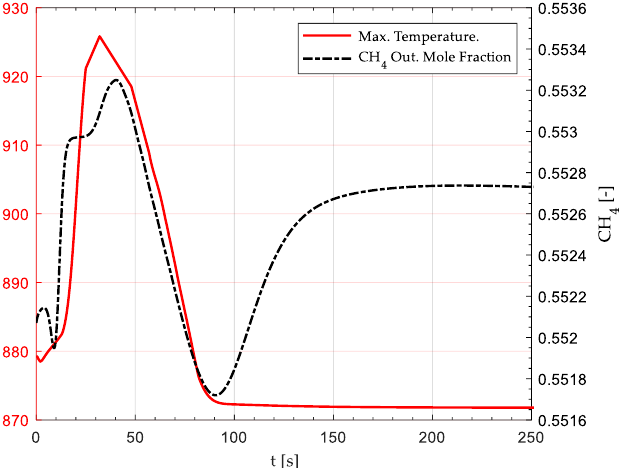
Figure 13. Effect of a 20 K step-drop in the feed gas (523 K to 503 K) on the maximum (Hot Spot) reactor temperature and CH 4 average outlet mole fraction. The disruption begins at t = 0, and a new steady state is established after t ≈ 200 s.